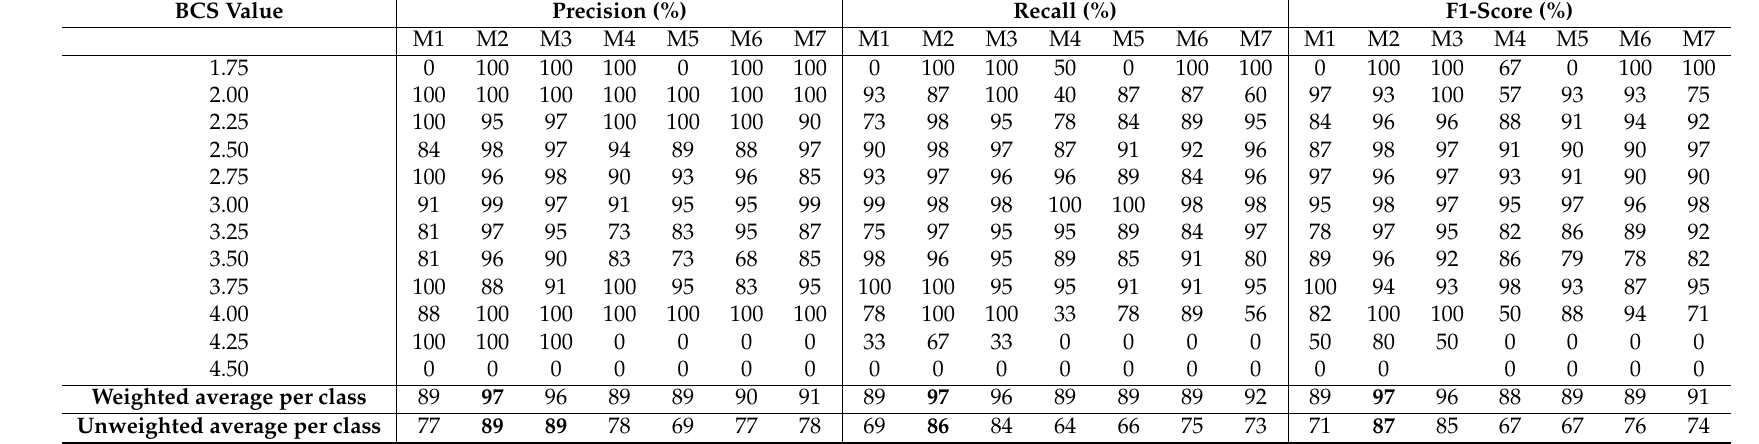
Table 5. Classification measures within 0.50 range error. Best results are in